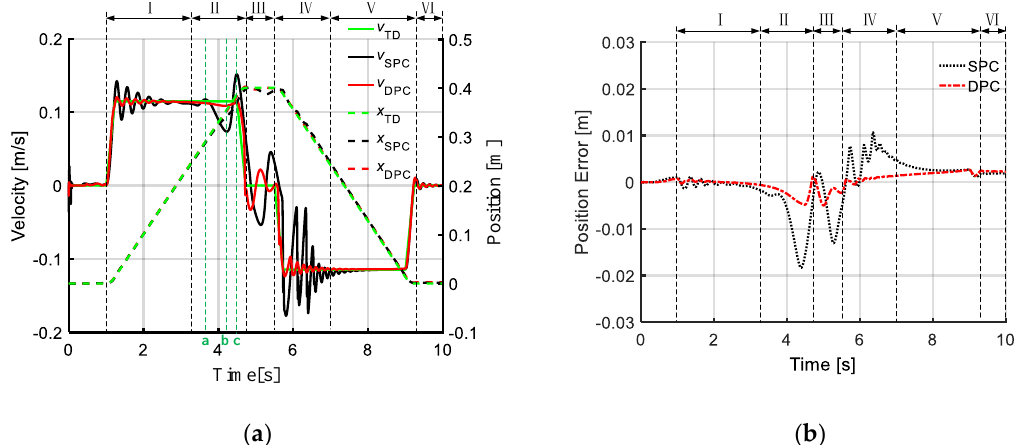
Table 4. Maximum velocity error and position tracking error of the SPC and DPC in each phase.